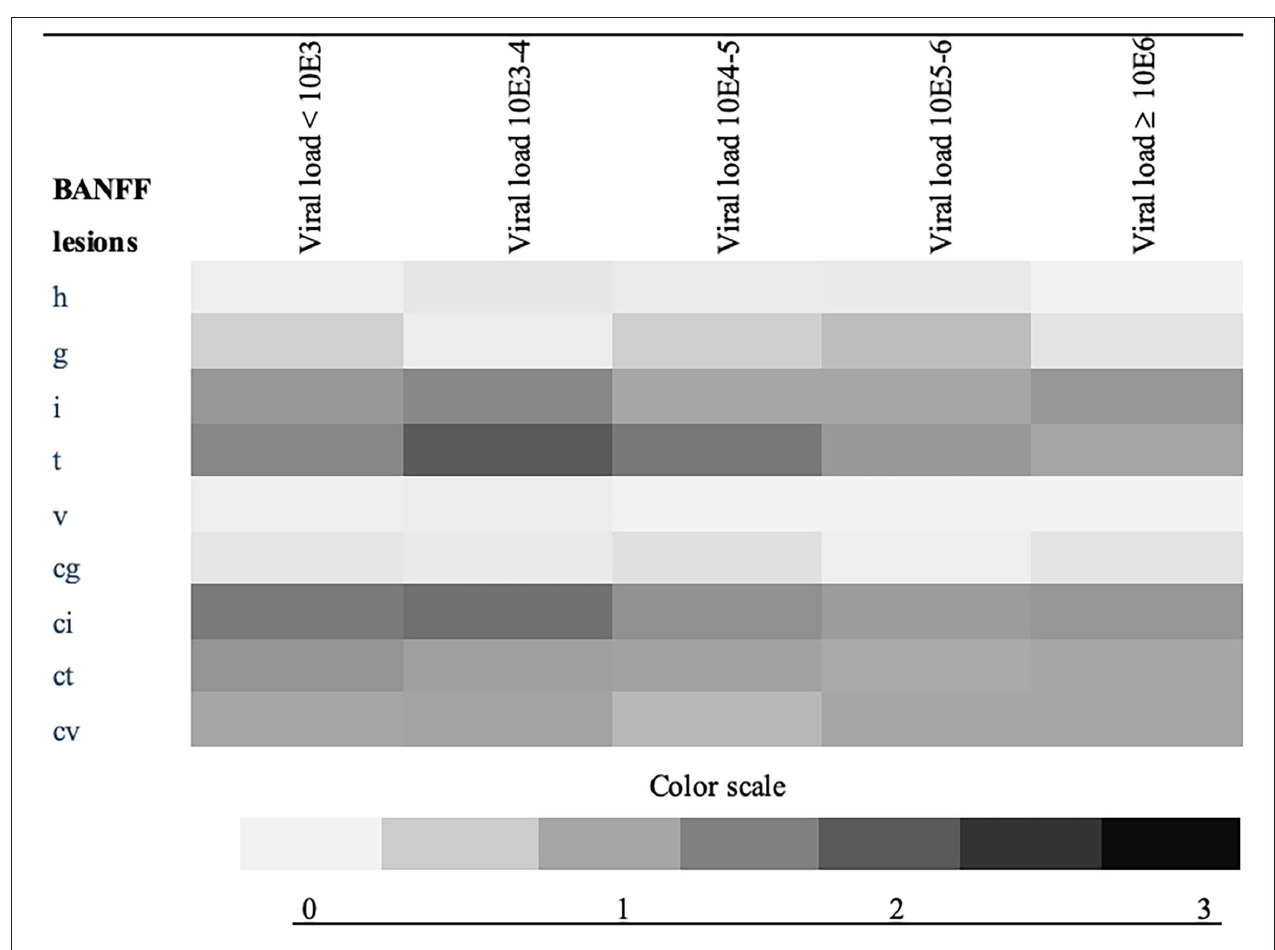
FIGURE 4 | Heat map of BANFF single lesions in the index biopsy in relation to absolute viral load; shows the mean value of BANFF scores (color scaled) at the index biopsy according to the viral load at the time of the diagnosis, (copies/ml), h, arteriolar hyalinosis; g, glomerulitis; i, interstitial inflammation; v, intimal arteritis; t, tubulitis; cg, transplant glomerulopathy; ci, interstitial fibrosis; ct, tubular atrophy; cv, arterial fibrous intimal thickening, color scale describes the mean score of each